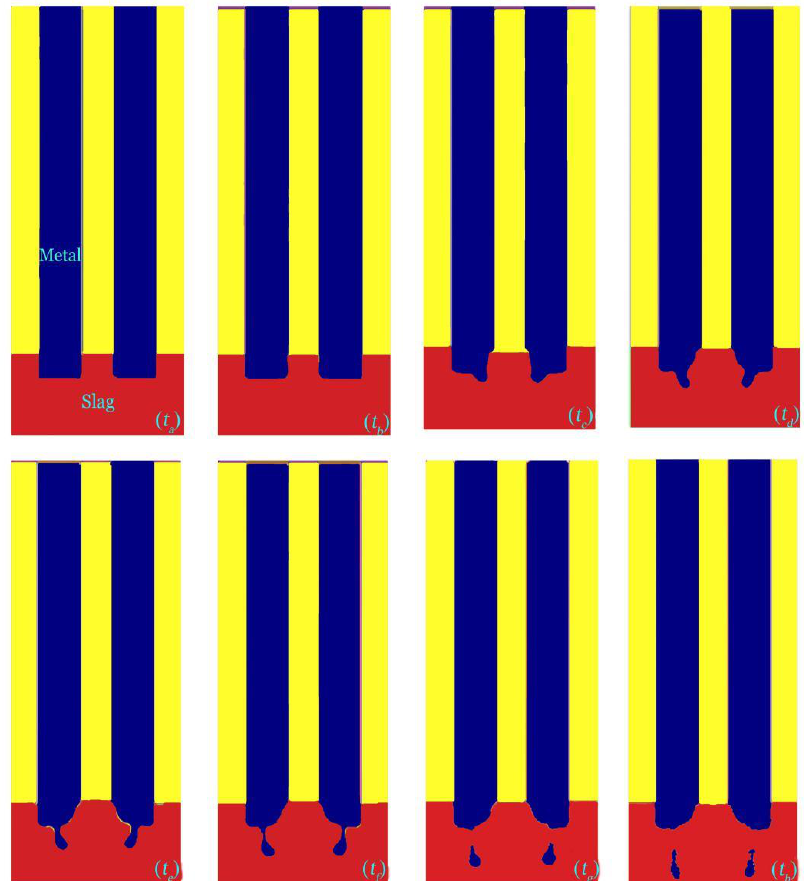
Figure 7. Formation and dripping process of the droplet with the filling rate of 0.5 in the numerical simulation. t a = 0.27 s; t b = 0.39 s; t c = 0.56 s; t d = 0.74 s; t e = 0.83 s; t f = 0.92 s; t g = 1.16 s; t h = 1.31 s.